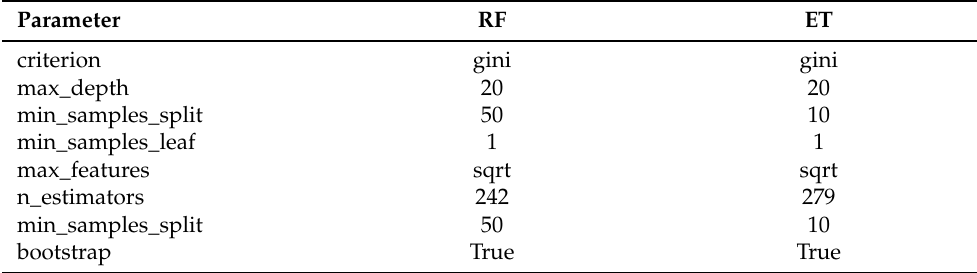
Table 8. Fine-tune Parameter values for Random Forests (RF) and Extra Trees (ET) Algorithms.